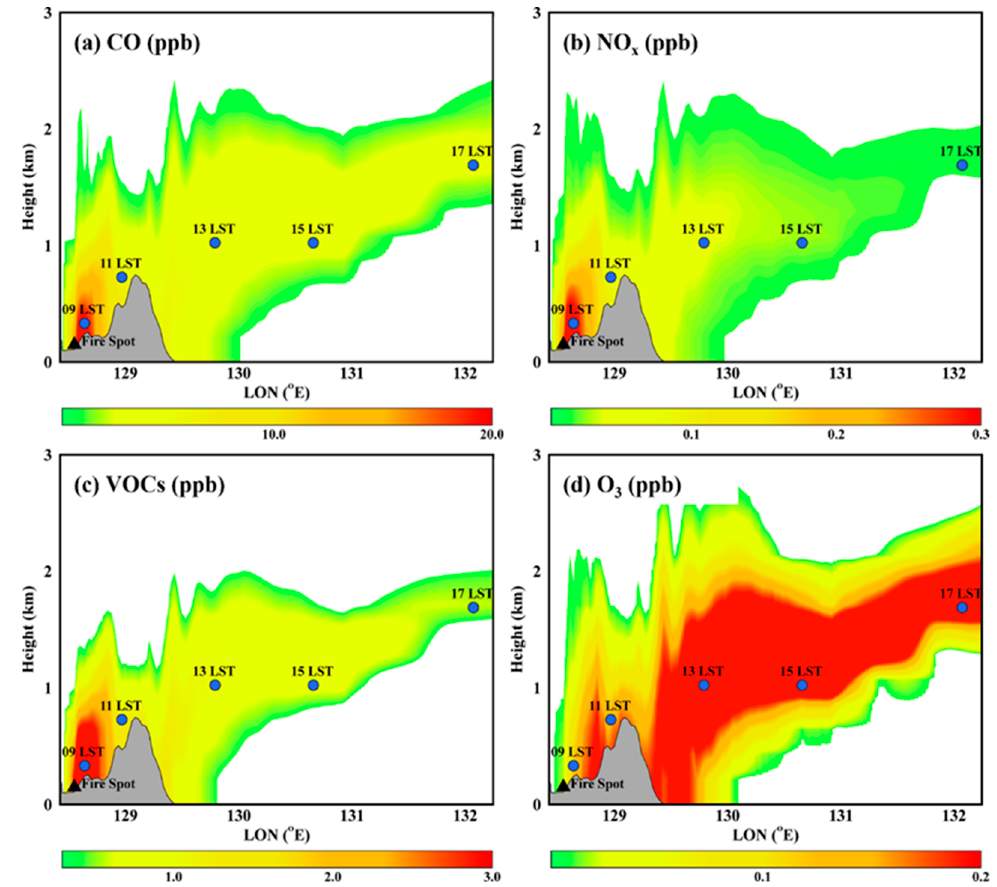
Figure 5. Vertical distribution of changes in concentration of primary pollutants (( a ) CO, ( b ) NO x , ( c ) VOCs) and ( d ) O 3 due to Andong wildfire (FINN_pbl—BASE). The concentration change values are the averages from 09 to 17 LST on 25 April 2020. The blue circle denotes the central location of the wildfire plume.